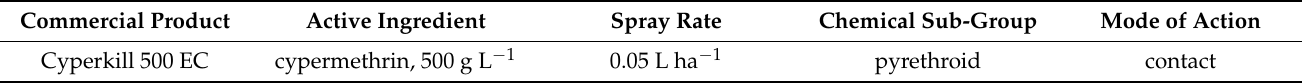
Table 1. Description of insecticide used against Sitona lineatus .